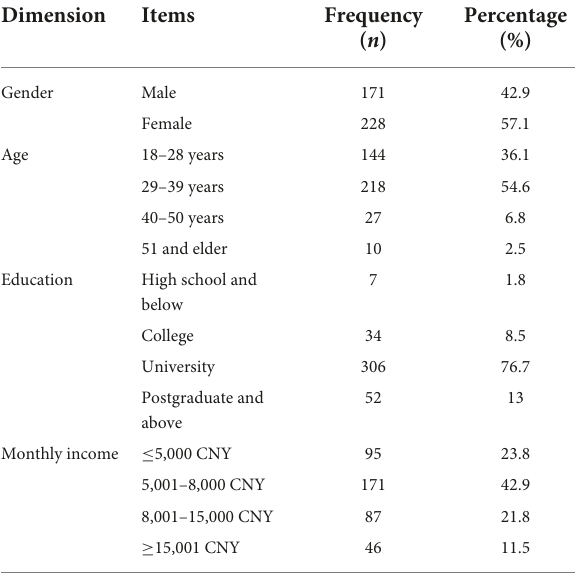
TABLE 1 Demographic characteristics ( n =